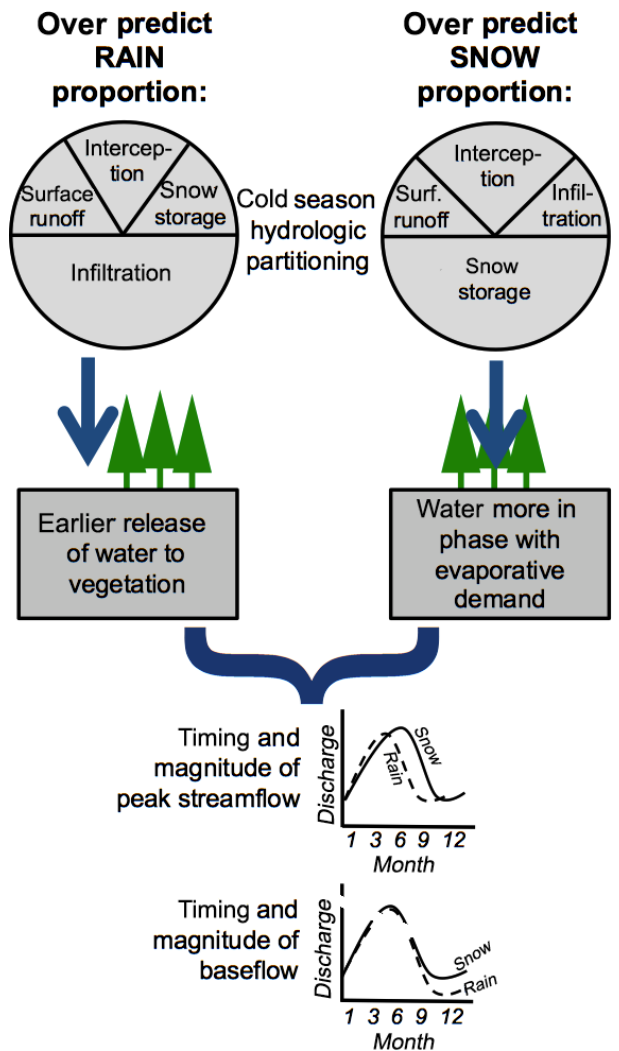
Figure 1. Precipitation phase has numerous implications for mod- eling the magnitude, storage, partitioning, and timing of water in- puts and outputs. Potentially affecting important ecohydrological and streamflow quantities important for